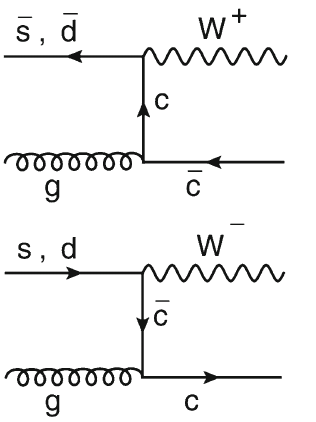
Fig. 1 Dominant contributions to W + c production at the LHC at lead- ing order in